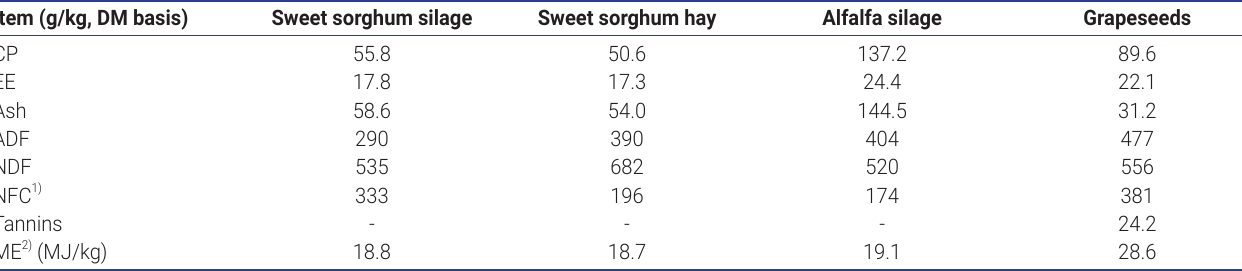
Table 1. Composition of sweet sorghum silage and hay, alfalfa silage and grapeseeds Item (g/kg, DM basis) Sweet sorghum silage